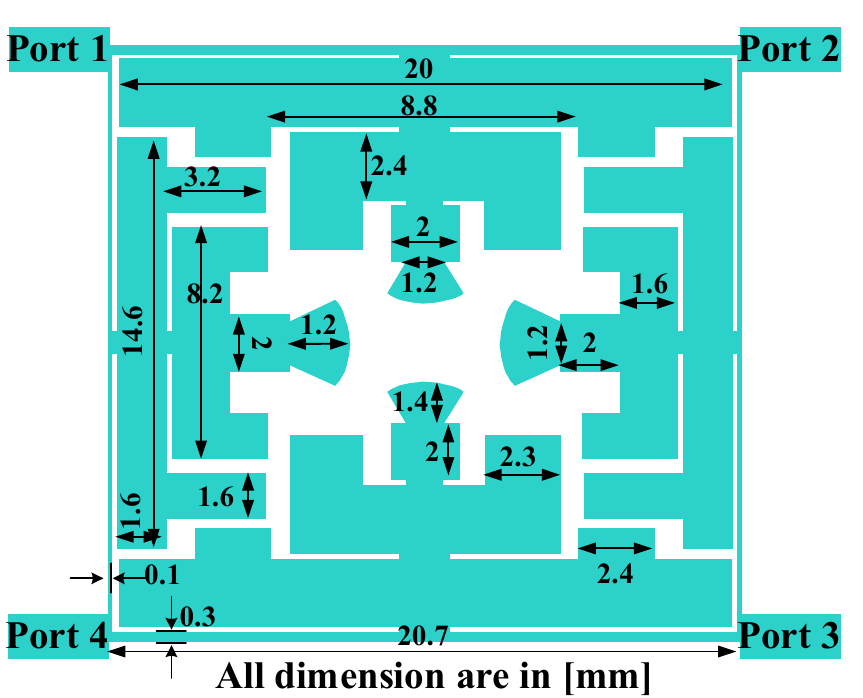
Figure 12. Structure of the proposed BLC.